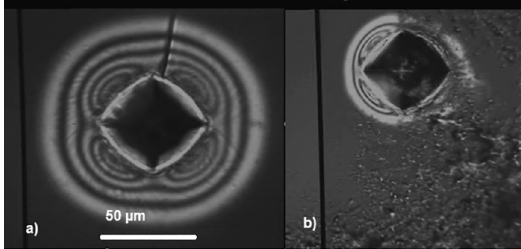
conventional polystyrene 39